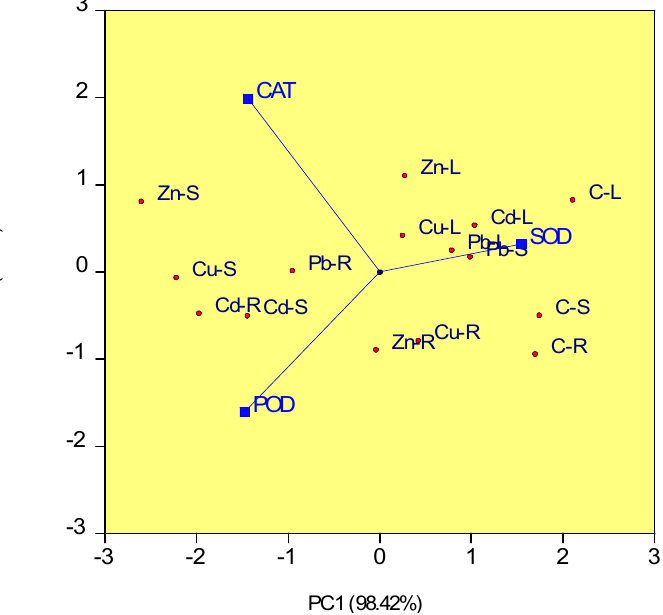
Figure 4. Principal component analysis (PCA) for antioxidant enzymatic activities of SOD, CAT) and POD in di ff erent organs of S. perfoliatum plants under control and heavy metals. C-R, roots of control plants; C-S, stems of control plants; C-L, leaves of control plants; Cu-R, roots of plants treated with Cu 400 ppm; Cu-S, stems of plants treated with Cu 400 ppm; Cu-L, leaves of plants treated with Cu 400 ppm; Zn-R, roots of plants treated with Zn 1200 ppm; Zn-S, stems of plants treated with Zn 1200 ppm; Zn-L, leaves of plants treated with Zn 1200 ppm; Cd-R, roots of plants treated with Cd 20 ppm; Cd-S, stems of plants treated with Cd 20 ppm; Cd-L, leaves of plants treated with Cd 20 ppm; Pb-R, roots of plants treated with Pb 400 ppm; Pb-S, stems of plants treated with Pb 400 ppm; Pb-L, leaves of plants treated with Pb 400 ppm.